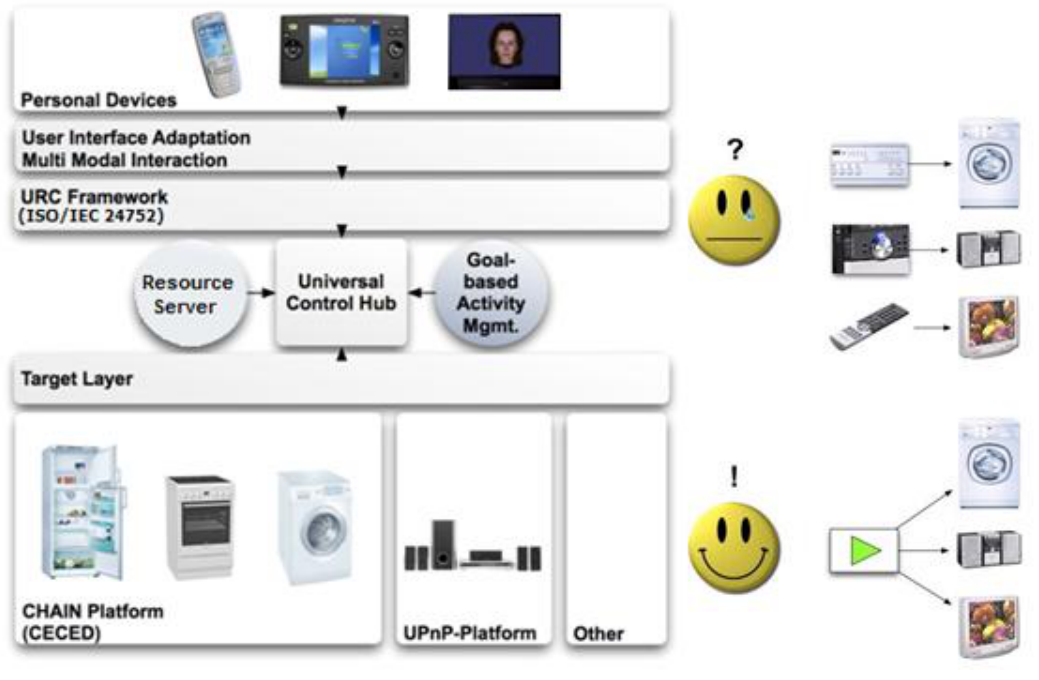
Figure 5. The Universal Remote Control standard. CECED = Conseil Européen de